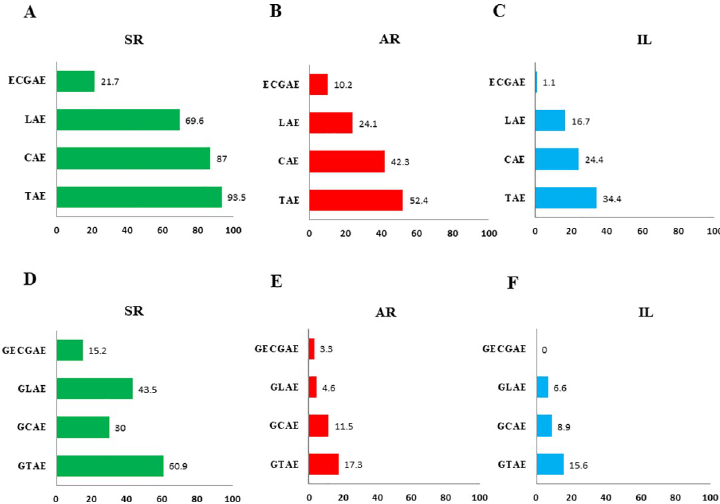
Fig 6. Adverse events among patients with cutaneous leishmaniasis treated with meglumine antimoniate according to the three groups. A) Number of cases of SR group with the occurrence of adverse events; B) Number of cases of AR group with the occurrence of adverse events; C) Number of cases of IL group with the occurrence of adverse events; D) Proportion of cases of SR group with moderate to severe adverse events, compared to the other groups; E) Proportion of cases of AR group with moderate to severe adverse events, compared to the other groups; F) Proportion of cases of IL group with moderate to severe adverse events, compared to the other groups. TAE- total adverse events; CAE- clinical adverse events; LAE- laboratory adverse events; ECGAE- Electrocardiographic adverse events; GTAE- grouped (moderate to severe) total adverse events; GCAE- grouped (moderate to severe) clinical adverse events; GLAE- grouped (moderate to severe) laboratory adverse events; GECGAE- grouped (moderate to severe) electrocardiographic adverse events; SR- standard regimen; AR- alternative regimen; IL- intralesional route.